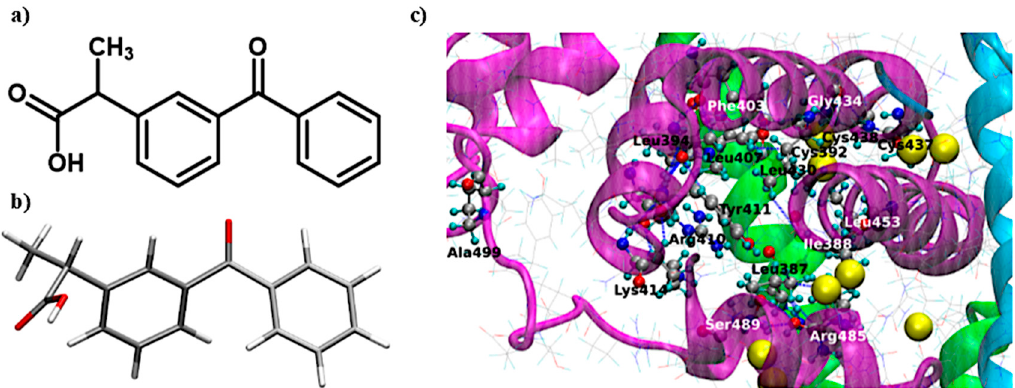
Figure 2. ( a ) Structure of ketoprofen; ( b ) lowest energy conformer of ketoprofen optimized within the B3LYP/6-311++G(d, p) approach in vacuum; and ( c ) Sudlow II site of HSA (PDB ID: 1AO6) with CPK representation for active site residues. The large yellow balls depict sulfur atoms.